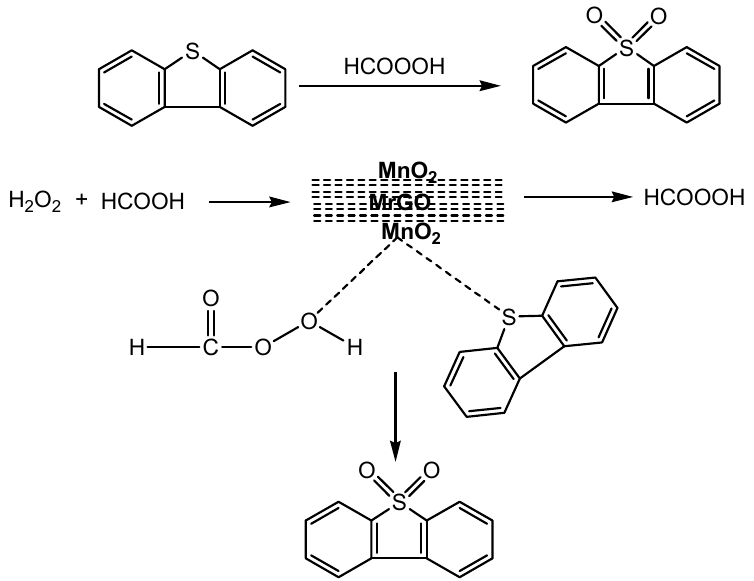
Scheme 1. Mechanism of ODS in the presence of MnO 2 /MrGO . The comparison between the efficiency of the current catalytic ODS processes using MnO 2 /MrGO catalyst and those reported in the literature are provided in Table 2. Various catalytic ODS processes that removed sulfur from modeled and real oil samples using different types of catalysts through the ODS process operated at longer reaction times and temperatures. In the current study, the ODS of modeled and commercial oil samples was operated at mild operating conditions, i.e., 60 min at 40 °C with high desulfurization yield, which is comparable to the reported ones. The current process exhibits high sulfur re- moval efficiency in a relatively shorter duration and lower temperature. In addition, the current process does not require an extraction step, which makes it economically feasible and a less time-consuming process. These results have suggested that the combination of MnO 2 and GO could be an excellent support offering enhanced ODS activity [34]. Table 2. A comparative analysis of the performance of ODS processes containing various catalysts and supports. Catalysts